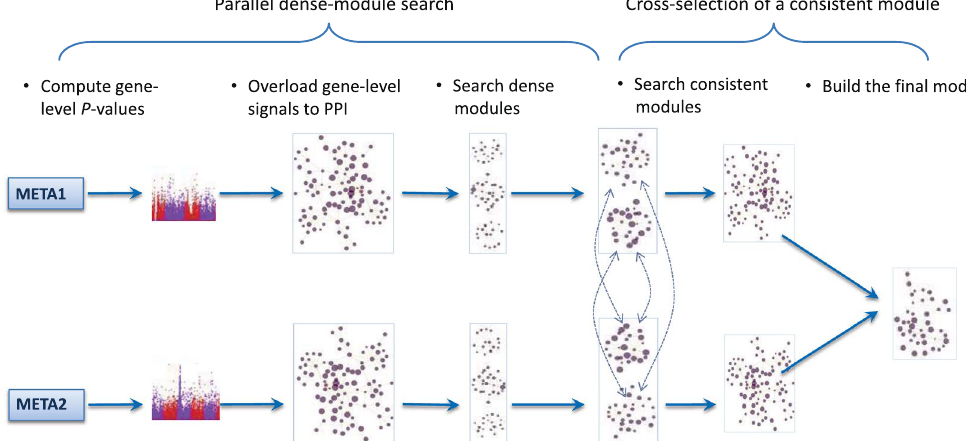
Figure 1. Workflow of the parallel dense-module search and cross-selection strategy. Individual SNP-level P -values from two independent childhood-onset asthma GWAS datasets (META1 and META2) were used as input for our network analysis. Gene-level P -values, computed from SNP-level P -values using fastCGP were converted to z-scores and overloaded to the PPI. The Dense Module Search algorithm was applied to each scored-PPI in parallel to search for dense modules. Modules with highest consistency between the two datasets were selected to build the final